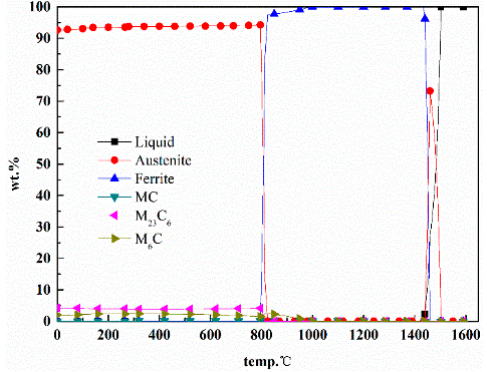
Figure 1. Thermodynamic calculation results for 25Cr3Mo3NiNb.